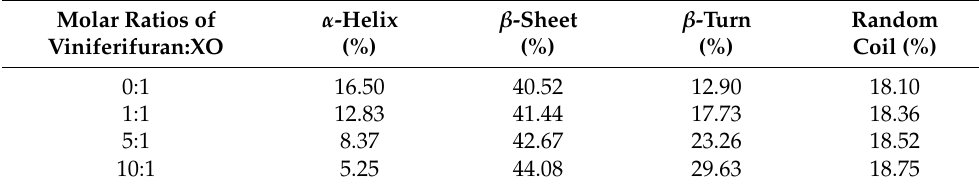
Table 2. The contents of different secondary structures of XO and its viniferifuran complex calcu- lated from CD data.